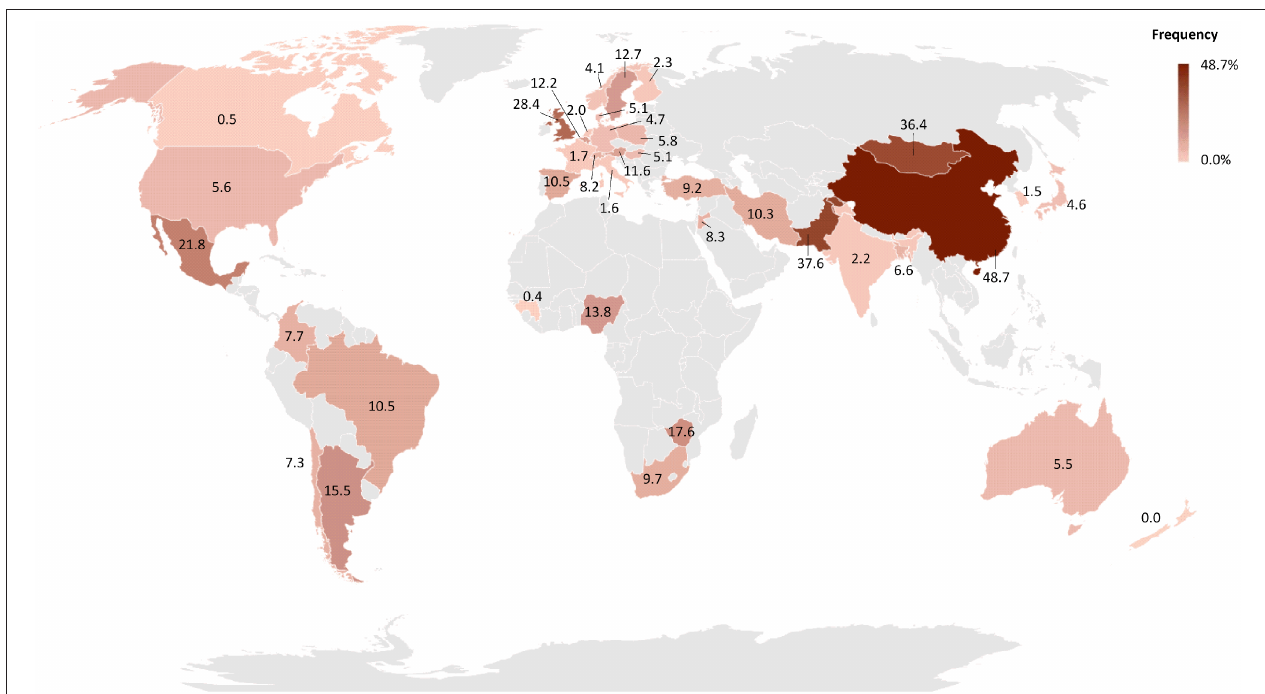
FIGURE 1 | Worldwide distribution of the frequency of B. canis infected dogs by country. The frequency of each country was obtained by weighted average of the frequency reported in each study available on PubMed and Google Scholar. The map was generated using Microsoft Excel software. Regions in gray indicate countries without epidemiological surveys while countries showing patterns with black lines indicate countries with reports of dogs infected with B. canis but without studies of disease